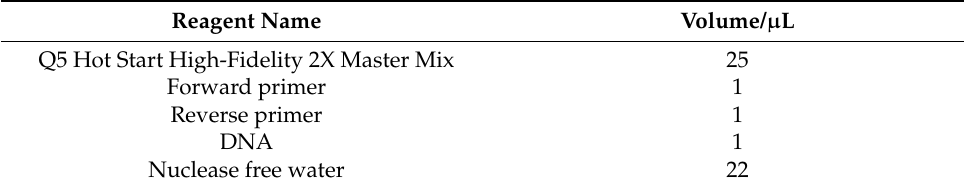
Table 2. The reaction system of PCR